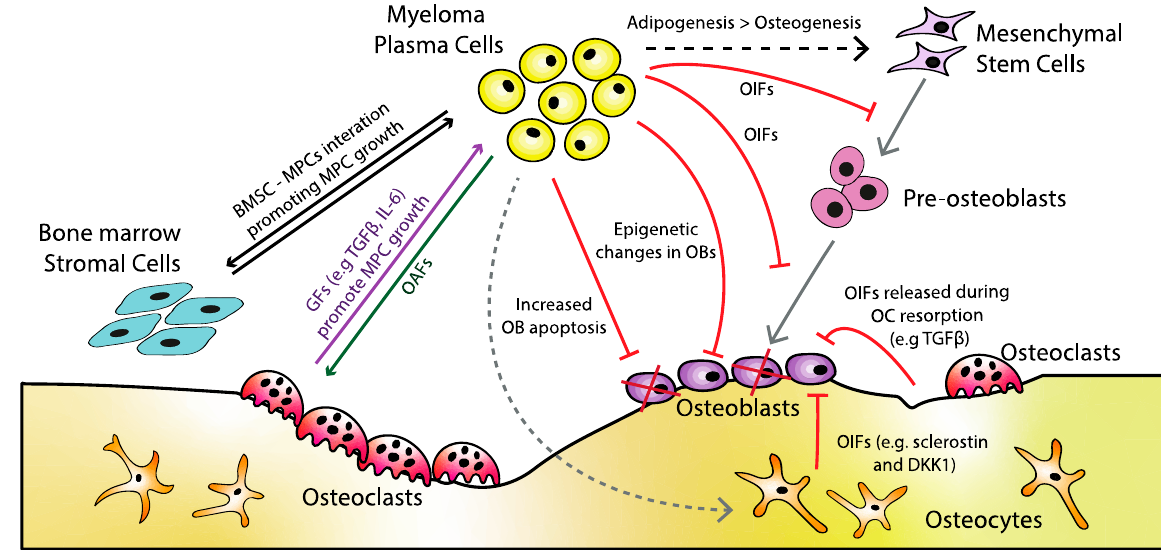
Figure 2. The inhibition of osteoblasts in myeloma bone disease. MPCs directly and indirectly promote OIFs that antagonise different stages of OB differentiation and maturation, as well as impacting on OB function. MPCs can also shift MSC differentiation towards a bias for adipogenesis (as opposed to osteogenesis), again deleting OB numbers. OBs exposed to MPCs are also more susceptible to apoptosis, as well as epigenetic changes that lead to long-term suppression of their function. The increased OC numbers and accelerated bone resorption seen in MBD also result in the release of growth factors (GFs) from the bone matrix, some of which further inhibit osteogenesis. MPCs have also been shown to increase the release of OIFs from OCYs, such as sclerostin. The GFs released during resorption, and MPCs adhesion to BMSCs, both enhance the homing and survival of MPCs, which further perpetuates OB inhibition and unopposed bone loss.